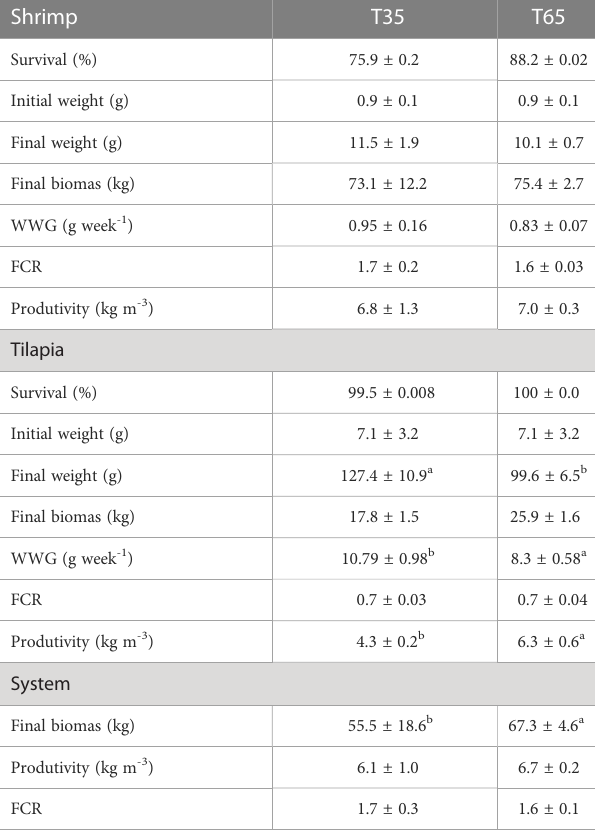
TABLE 2 Performance of L. vannamei and O. niloticus (mean values ± standard deviation) during the experimental period. Shrimp